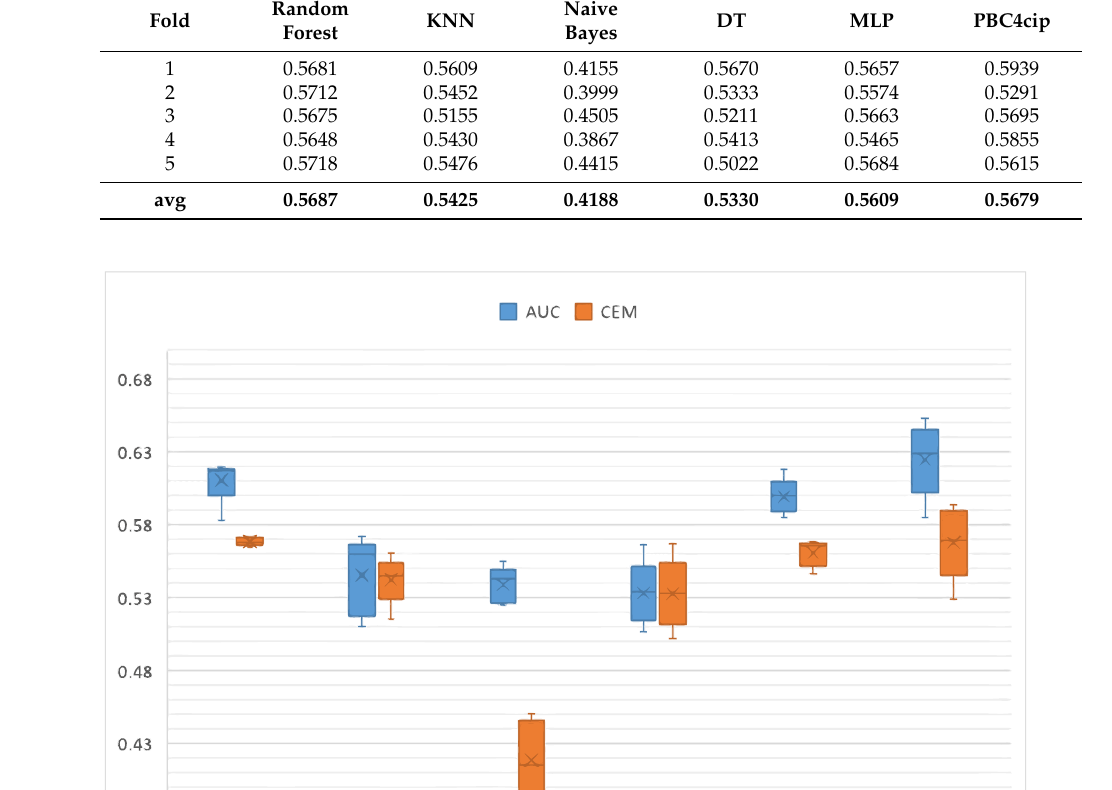
Table 5. Cross-validation CEM results.